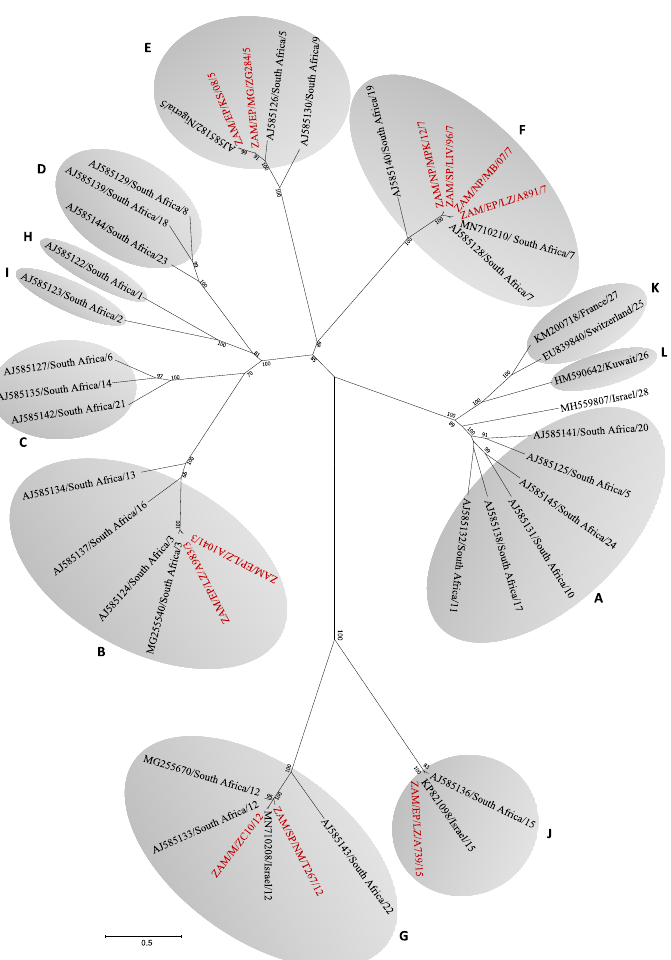
Figure 2. Phylogenetic tree of segment 2 gene of viruses detected in this study. The tree was generated using the Maximum Likelihood method based on the general time reversable (GTR) model with 1000 bootstrap replicates. Numbers at branch nodes indicate bootstrap values ( > 60%). Viruses characterized in the present study are in red text. Shaded area and letters represent BTV nucleotypes. References sequences for BTV1 to 28 are in black text. Bar—number of nucleotide substitutions per site. Abbreviations: EP, Eastern Province; SP, Southern Province; WP, Western Province; NP, Northern Province; LZ, Lundazi; MG, Mongu; LIV, Livingstone; NM, Namwala; MB, Mbala; KS, Kasama; MPK,